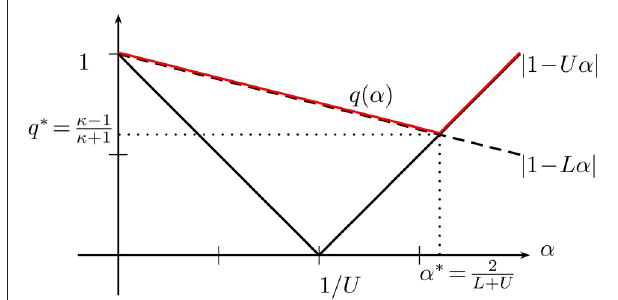
max α L α U 1 , 1 = {| − | | − |}